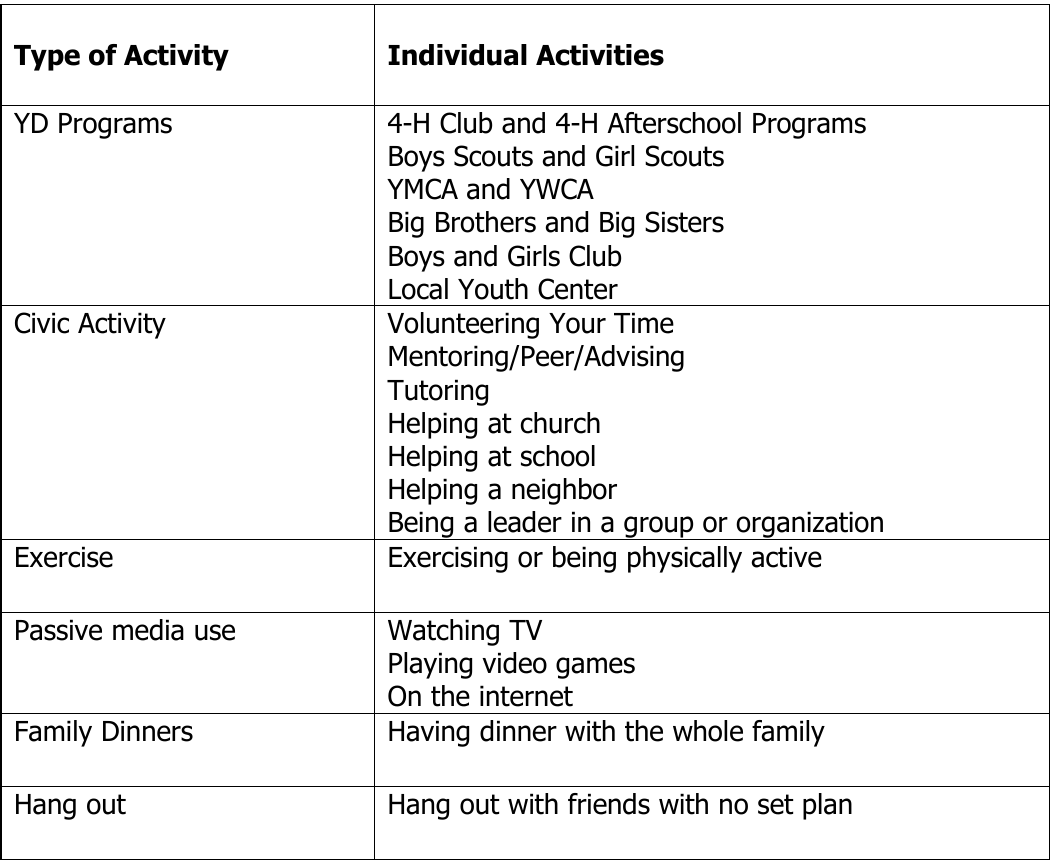
Participation in out-of-school time activities in Grade